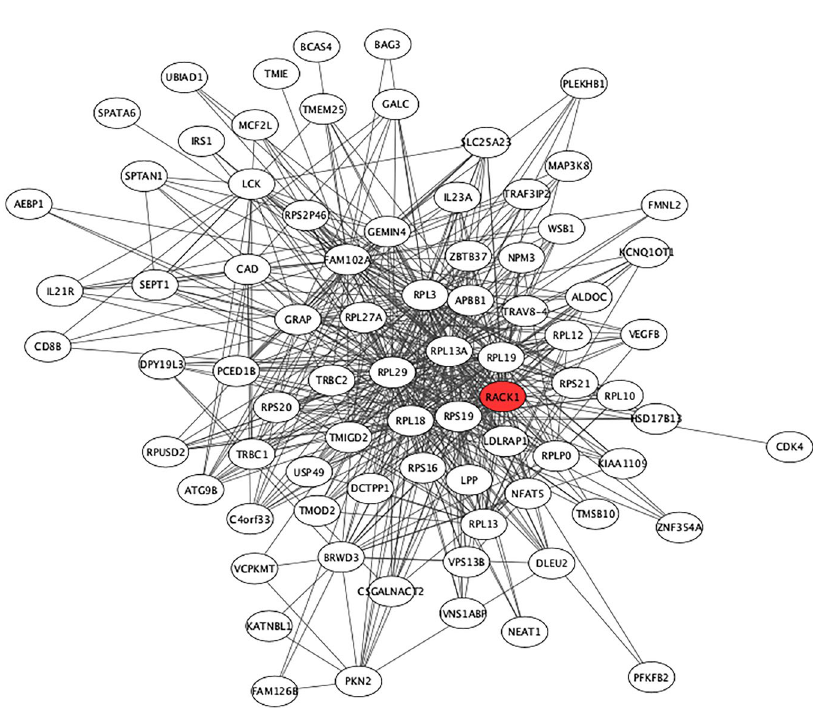
Figure 5. The “midnight blue” coexpression network. The figure was generated using using Cytoscape 31 , and the hub gene RACK 1 is highlighted in